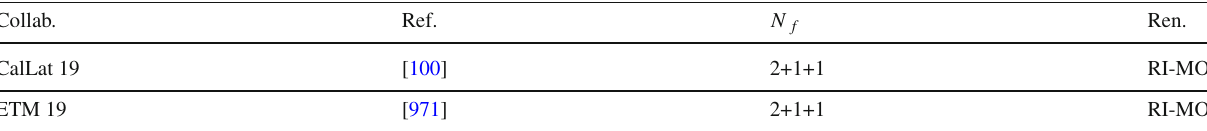
Table 180 Renormalization in determinations of the isovector axial, scalar and tensor charges with N f = 2 + 1 + 1 quark flavours Collab. Ref.